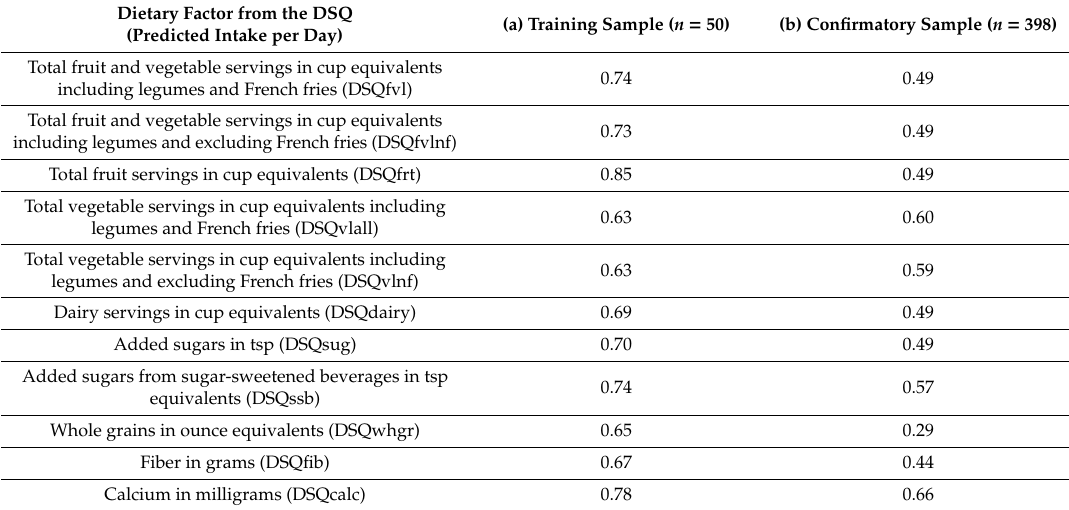
Table 3. The Pearson’s Correlation between the sHEI and the DSQ. Dietary Factor from the DSQ (Predicted Intake per